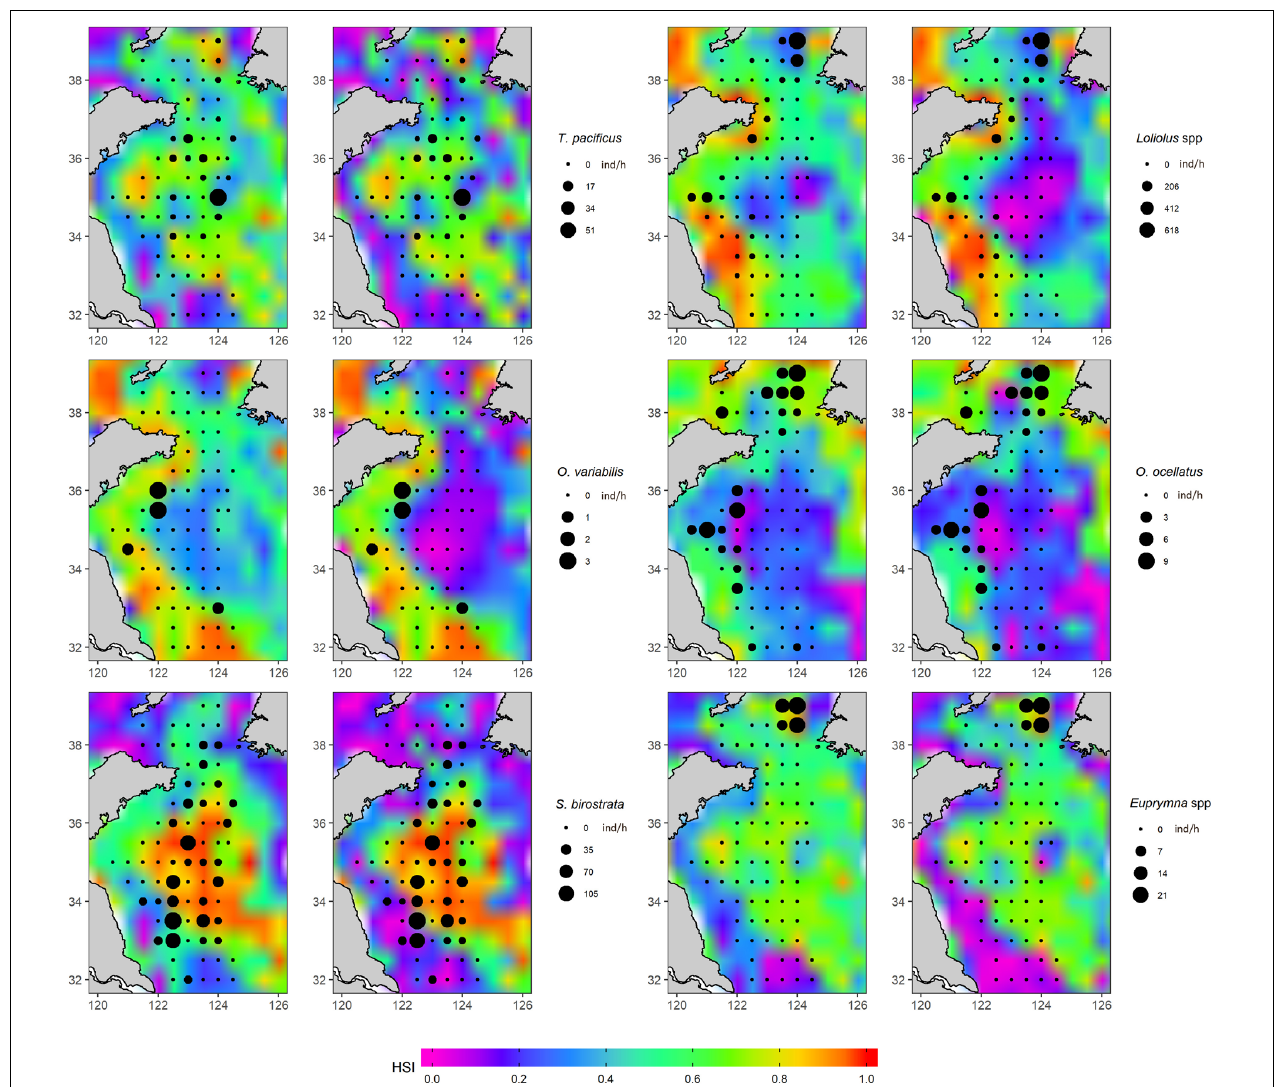
FIGURE 9 | Habitat suitability index (HSI) map of cephalopods predicted based on the oceanographic data (sea surface temperature and chlorophyll-a concentration) in 2018 using an arithmetic mean model (AMM) and a geometric mean model (GMM) developed with data from 2000 to 2017. A cephalopod abundance index (AI) distribution from 2018 was overlaid on the HSI map. The left panel of each species represents its respective AMM, and the right panel of each species represents its respective